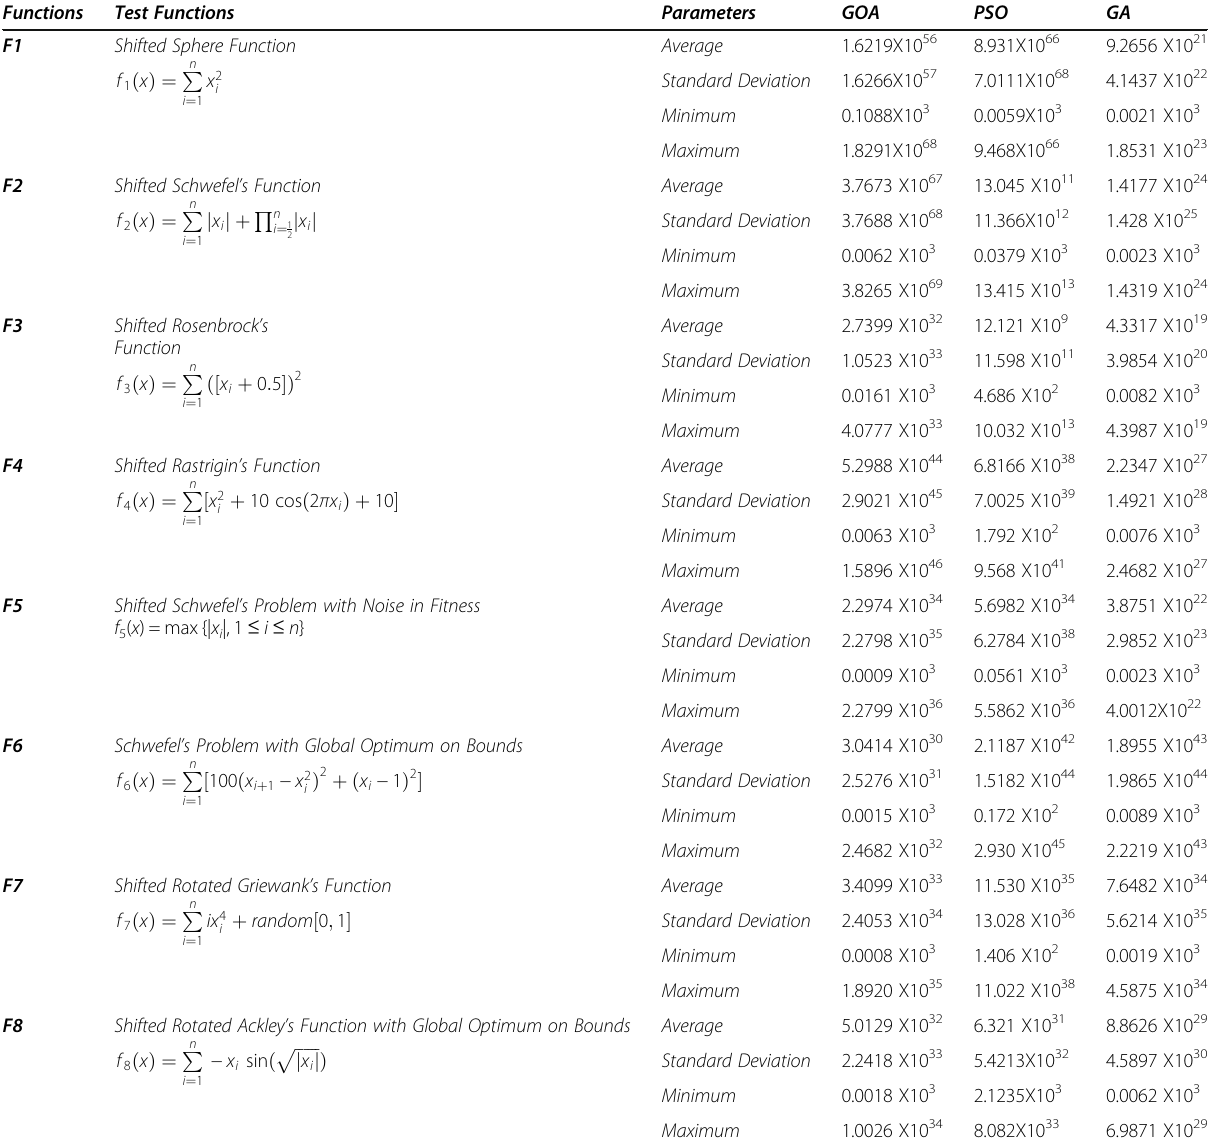
Table 1 Statistical analysis of different agents for GOA, PSO and GA optimized PDF plus (1+ PI) controllers Functions Test Functions Parameters GOA